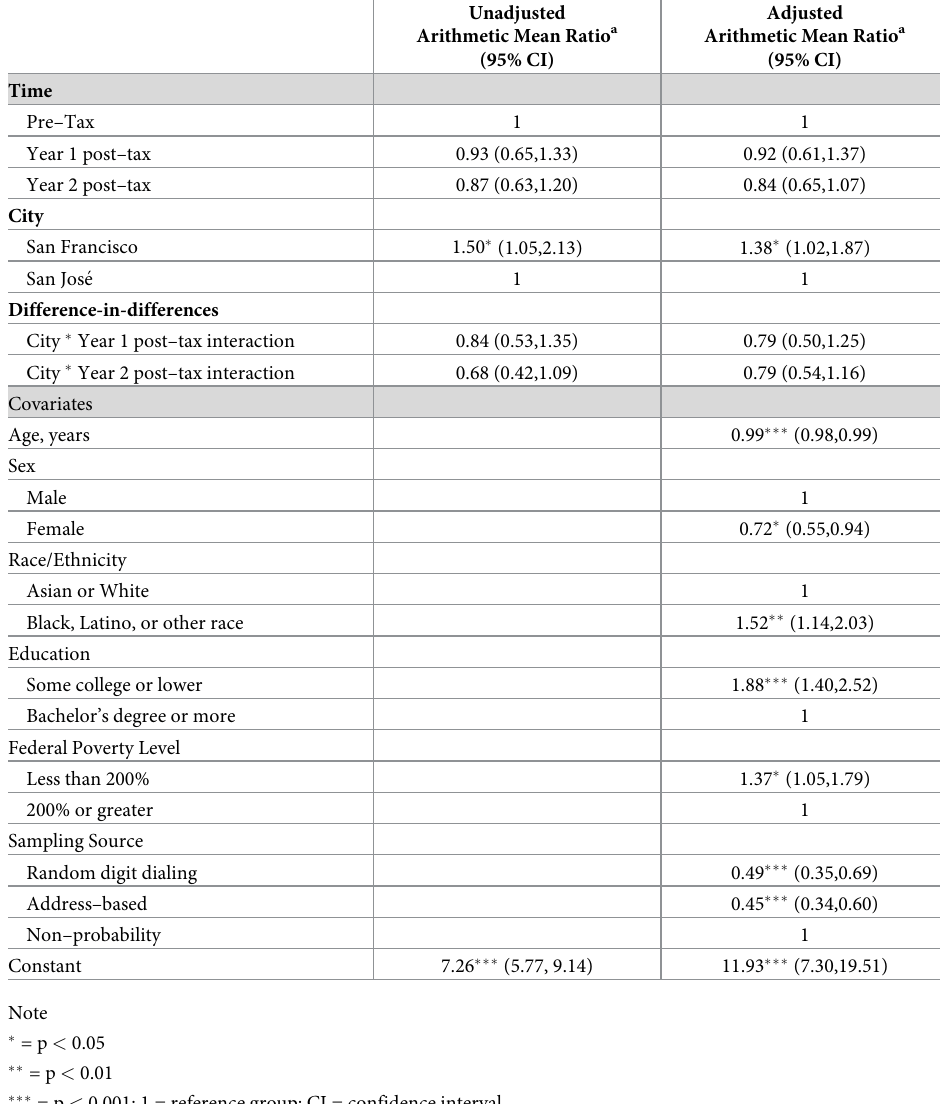
Table 2. Difference-in-differences of sugar-sweetened beverage consumption (ounces) pre- and post-tax imple- mentation between San Francisco and San Jose´ pre- and post-tax implementation (n = 1,443).